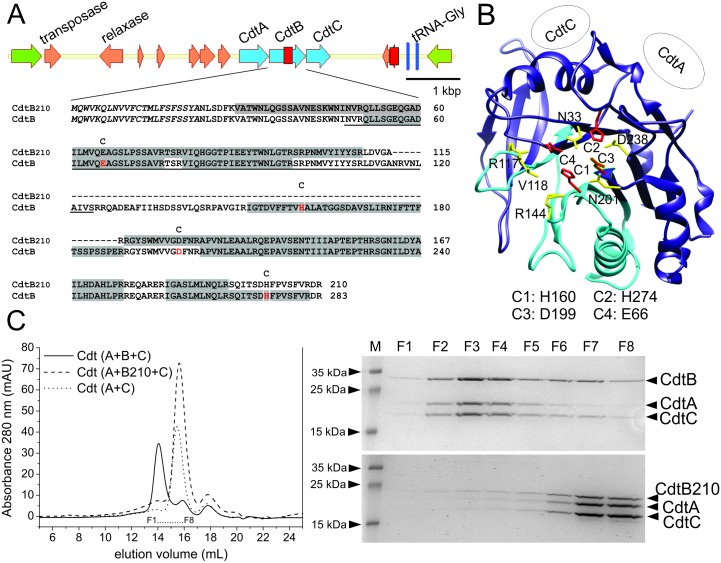
CdtB210 lacks the critical catalytic residue H160, and does not form a holotoxin.(A) Genetic map of the genomic island of the A. actinomycetemcomitans isolate DO15 that harbors cdtB210 with the aligned CdtB amino-acid sequences expanded. Flanking genes, chromosomally encoded genes (green), genomic island genes (orange), and cdt operon determinants (blue) are marked. The two red boxes designate the regions absent on genomic island of the DO15 strain. First red box: 219 bp missing in cdtB210. The deletion includes part of the nuclear localization signal (underlined) and the catalytic H160, critical for DNase activity. The H160, D199, E66 and H274 involved in catalysis are shown (red). The first 22 amino-acid residues in italics designate the signal sequence. The shaded residues were identified by mass spectrometry peptide mapping. Peptides spanning the deletion were identified only in the secretome of the CdtB-producing strain. (B) Structure of A. actinomycetemcomitans CdtB (blue, PDB 2f2f, chain B) with the region missing in CdtB210 (cyan). Residues involved in catalysis (red sticks, and at the bottom) and substrate/ metal binding (yellow sticks) are shown. The contacts between the CdtB, CdtA, and CdtC proteins in the holotoxin are presented schematically. (C) Analysis of the oligomeric state of CdtB and CdtB210 premixed (equimolar) with CdtA and CdtC. CdtA plus CdtC was used as the control. Molecular mass analysis of the CDT complexes was performed on a Superdex 200 column. F1 to F8: fractions assayed using SDS-PAGE analysis (shown right), which indicated that CdtB, but not CdtB210, formed the tripartite complex.